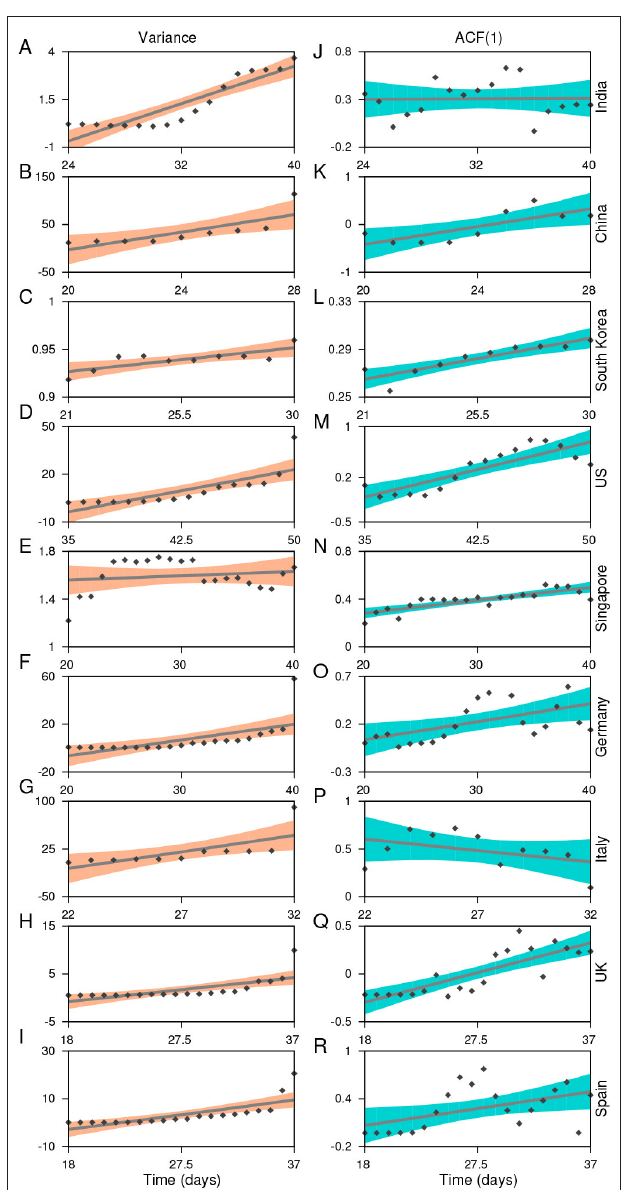
FIGURE 2 | Statistical estimates used to analyze the signals of a forthcoming transition in the COVID-19 incidence curve. (A-I) : Figures on the left panel depicts the variance each for India, China, South Korea, USA, Singapore, Germany, Italy, UK, and Spain. (J-R) : The right panel shows the lag-1 autocorrelation of the time series data analyzed in the corresponding countries. Scattered points are the estimated values of the respective slowing down indicators. Solid lines reflect the increasing/decreasing trend in the indicators and are obtained by fitting linear regression models. The shaded regions are the confidence bounds for the fitted models.